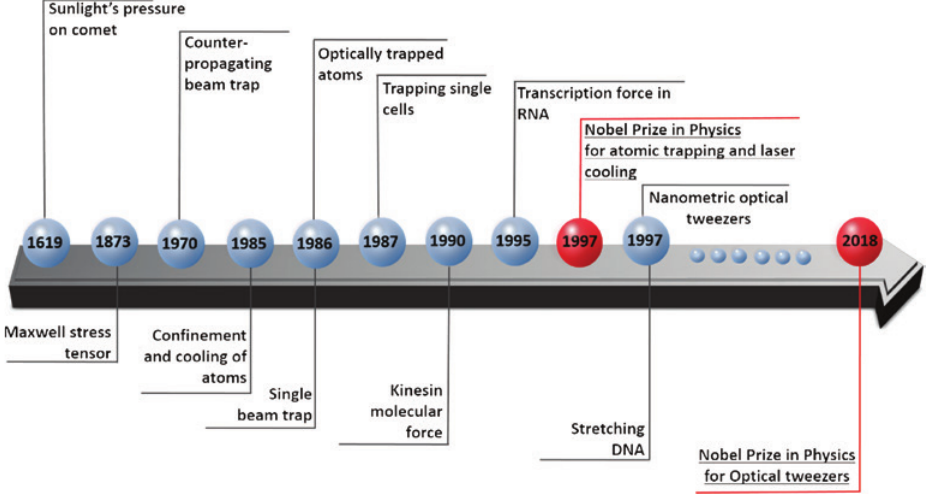
Figure 1: The optical tweezers roadmap [1, 2,